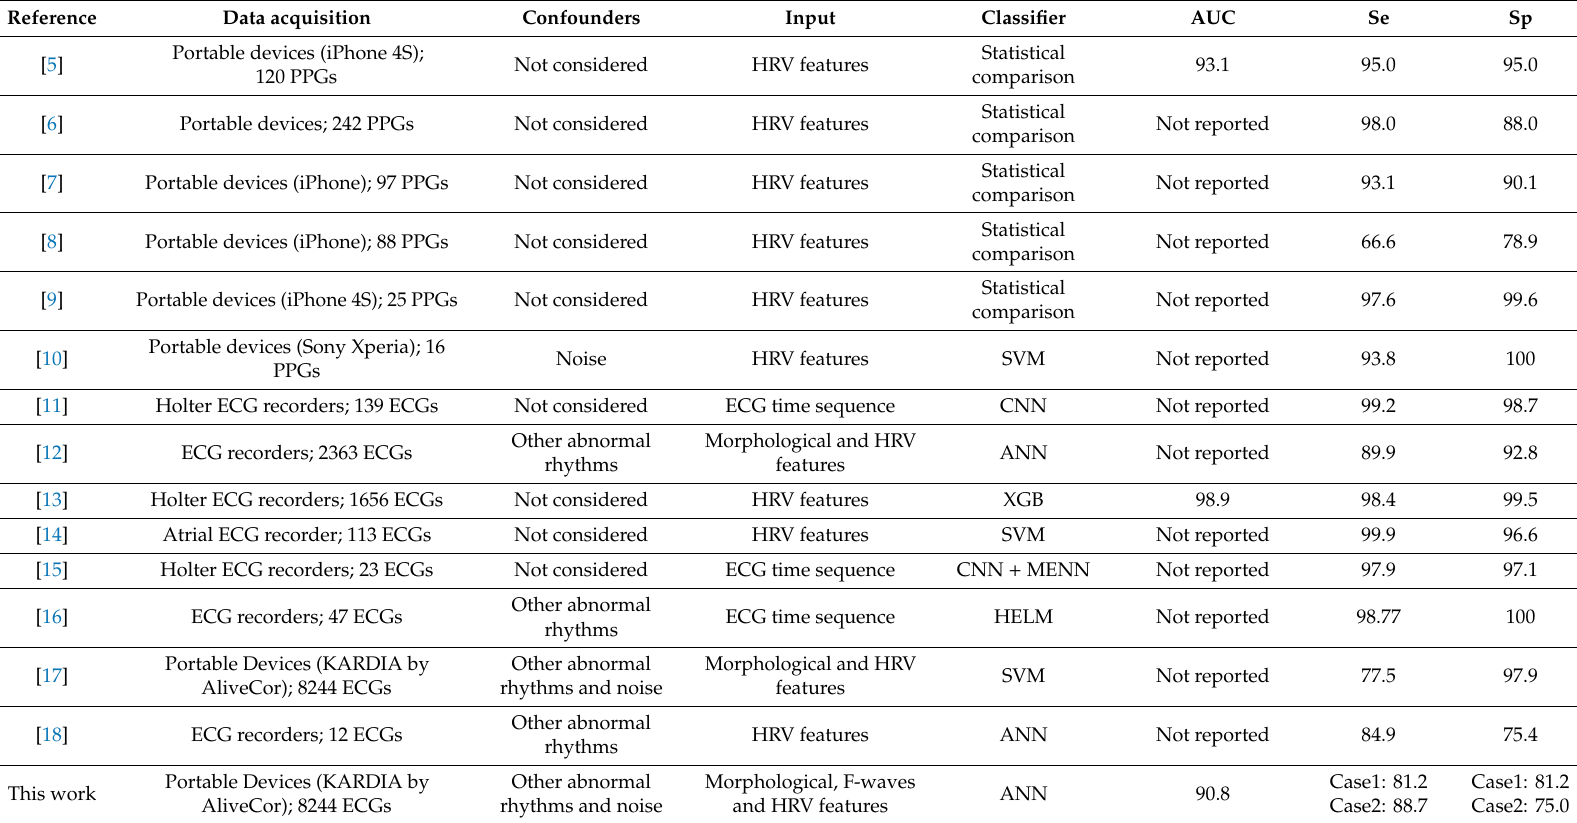
Table 4. Comparison between our work and the